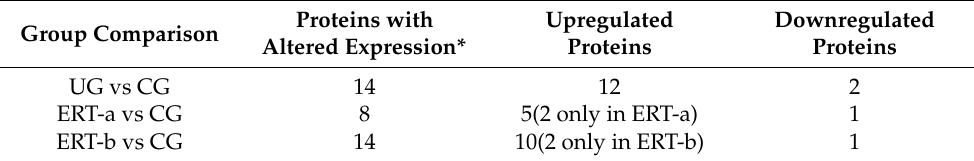
Table 1. Changes in plasma protein expression detected by SWATH in any of the patient groups (UG, ERT-a, or ERT-b) relative to the control